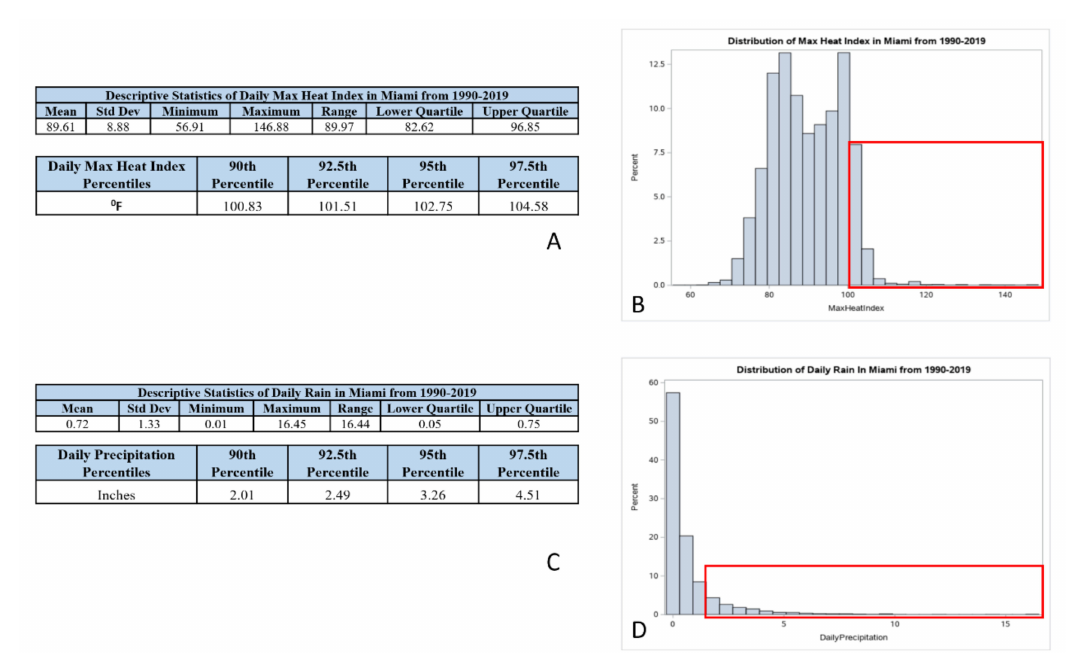
Figure A1. 1990–2019 Retrospective analysis of NOAA weather data collected every hour from January 1990 to October 2019 at Miami International Airport’s zip code, located 3.5 miles from the institution. ( A ): SAS software analysis from the maximum daily Heat Index Calculation*. Top= Descriptive statistics: mean, median, minimum, maximum, standard deviation, and lower and upper quartiles. Bottom= Percentiles (1): 90th, 92.5th, 95th, and 97.5th. ( B ): A maximum heat index normality curve with a bell-shaped bimodal presentation. Red boxes indicate all values that are considered extreme at Miami International Airport weather station’s (MIAs) zip code 33142, located 3.6 miles from the institution location. ( C ): SAS Analysis from daily hourly-precipitation. Top= Descriptive statistics: mean, median, minimum, maximum, standard deviation, lower and upper quartiles. Bottom= Percentiles (1): 90th, 92.5th, 95th, and 97.5th. ( D ): Daily rain normality curve. Distribution bell shape is not presented, as this is a binary variable. Red boxes indicate all values that are considered extreme at Miami International Airport weather station’s (MIAs) zip code (33142), located 3.6 miles from the institution location. * Heat Index (HI) was calculated using the data points of temperature (T) and relative humidity (RH) by the computation of Rothfusz multiple regression formula (HI = − 42.379 + 2.04901523 × T + 10.14333127 × RH − 0.22475541 × T × RH − 0.00683783 × T × T − 0.05481717 × RH × RH + 0.00122874 × T × T × RH + 0.00085282 × T × RH × RH − 0.00000199 × T × T × RH × RH. The heat index formula was adjusted as suggested by NOAA: if “RH is less than 13% and the temperature is between 80 and 112 degrees F”, then ADJUSTMENT = [(13-RH)/4] × SQRT{[17-ABS(T-95.)]/17} where ABS is absolute value and SQRT is square rot functions. However, if “RH is greater than 85% and the temperature is between 80 and 87 degrees F”, then ADJUSTMENT = [(RH-85)/10] ×